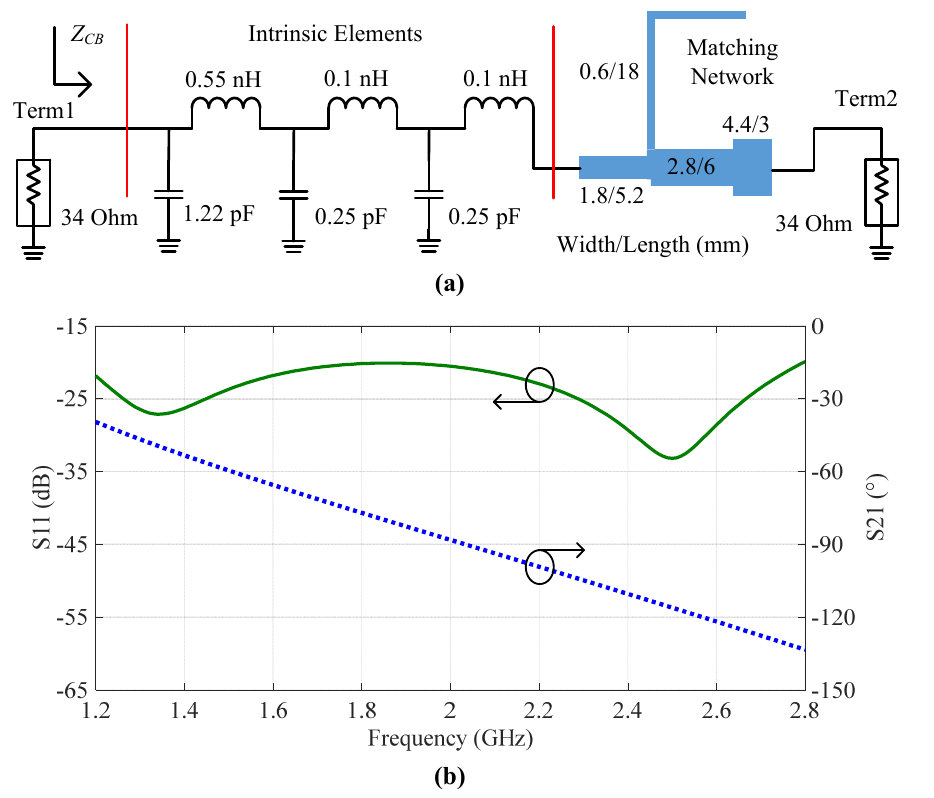
Figure 4. ( a ) Schematic and ( b ) simulation results of the impedance inverter TL1, which is composed of the intrinsic elements of the carrier transistor and a matching